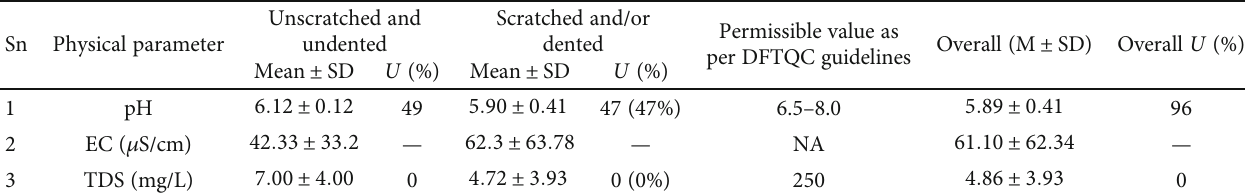
Table 1: Association between physical parameters (as per DFTQC guideline), bottle type.